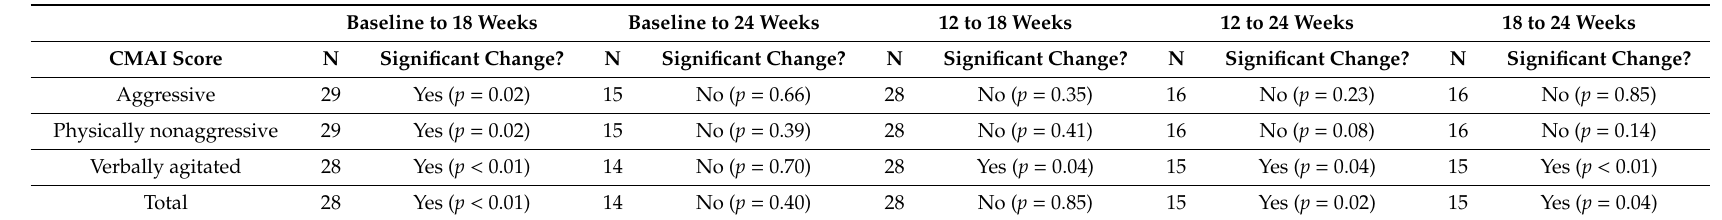
Table 8. Statistical significance of proportional change to CMAI scores over time.